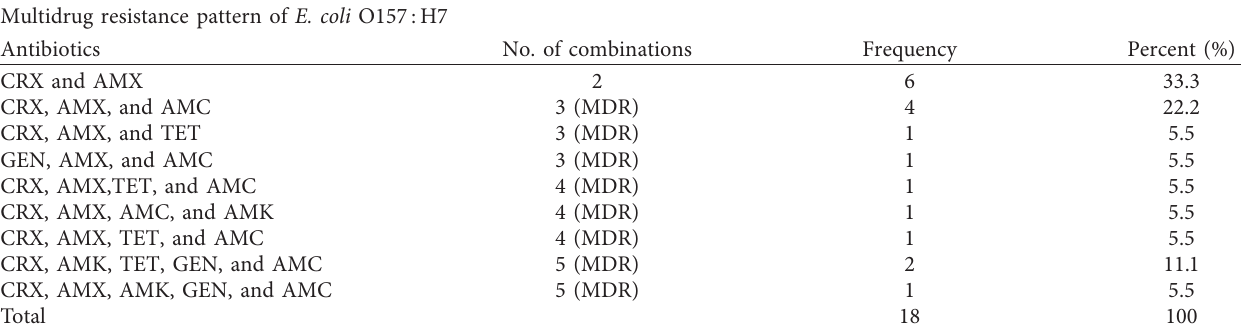
Figure 2: Antimicrobial susceptibility test result of E. coli O157 :H7 isolated from raw beef at abattoir and retailer shops in Ambo town, West Shewa, Ethiopia. CRX: cefuroxime, NOR: norfloxacin, CPR: ciprofloxacin, CHL: chloramphenicol, TET: tetracycline, TSX: tri- methoprim-sulfamethoxazole, GEN: gentamycin, CTX: cefotaxime, NIT: nitrofurantoin, CAZ: ceftazidime, AMK: amikacin, AMX: amoxicillin, and AMC: amoxicillin-clavulanate. Table 5: Multidrug resistance pattern of E. coli O157:H7 from abattoir and retailer shops in Ambo, West Shewa, Ethiopia (January 2016 to May